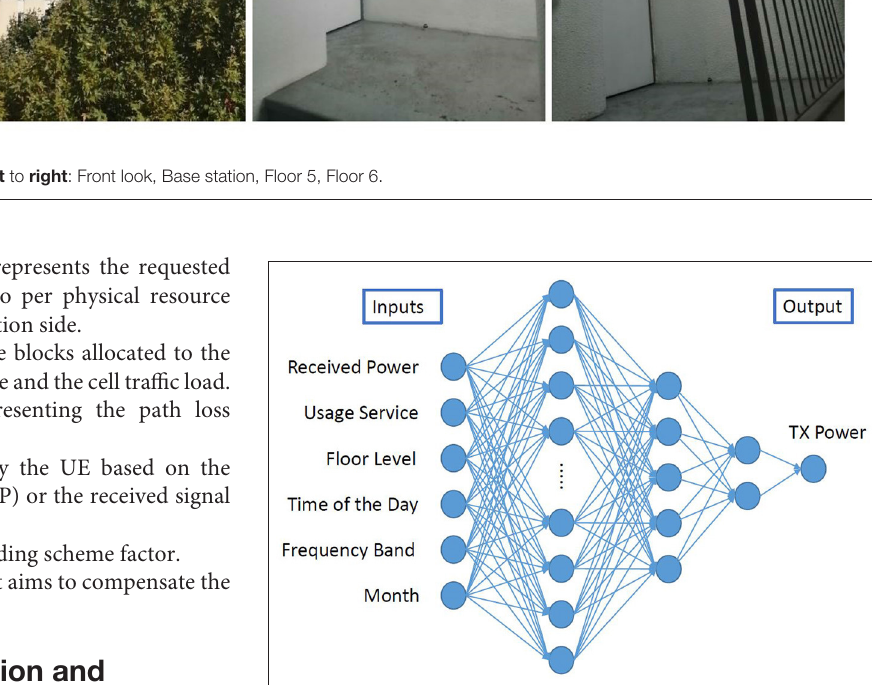
FIGURE 2 | Artificial neural network